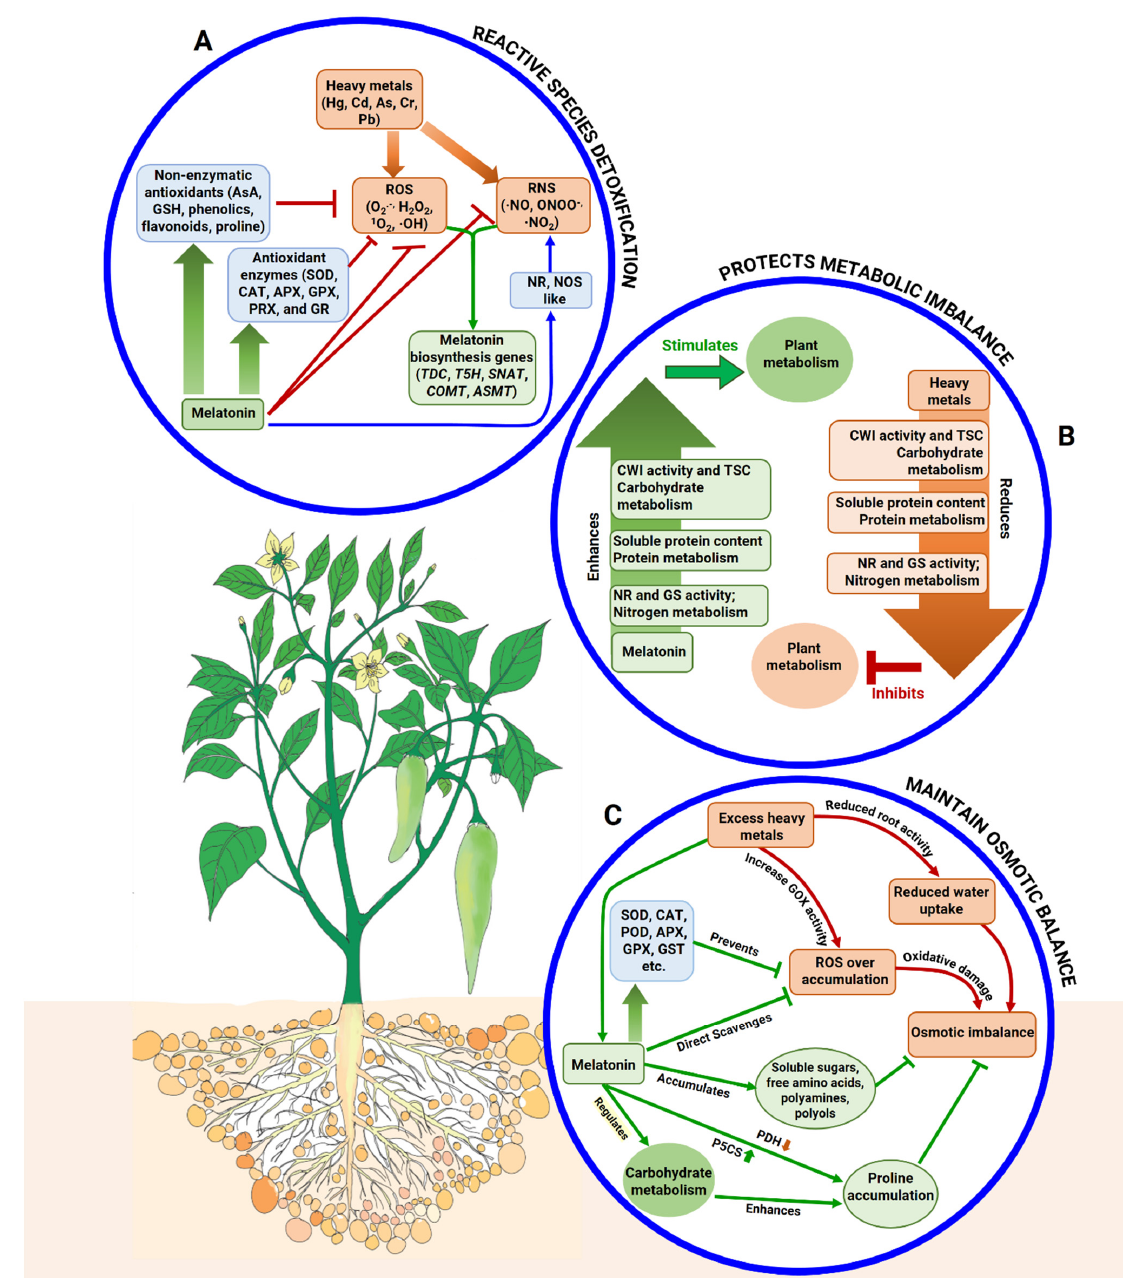
Figure 2. Diagram showing mechanism of MT-mediated ( A ) reactive species detoxification, ( B ) protection against metabolic imbalance, and ( C ) maintenance of osmotic balance under HM stress conditions. ( A ) ROS: reactive oxygen species,